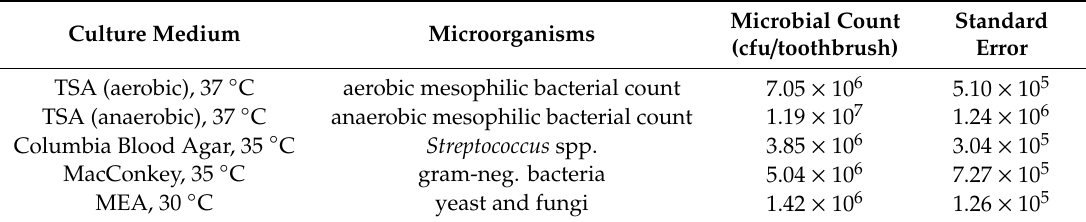
Table 5. Microbial count of the tested toothbrushes on di ff erent culture media. Means with standard error are shown ( n =